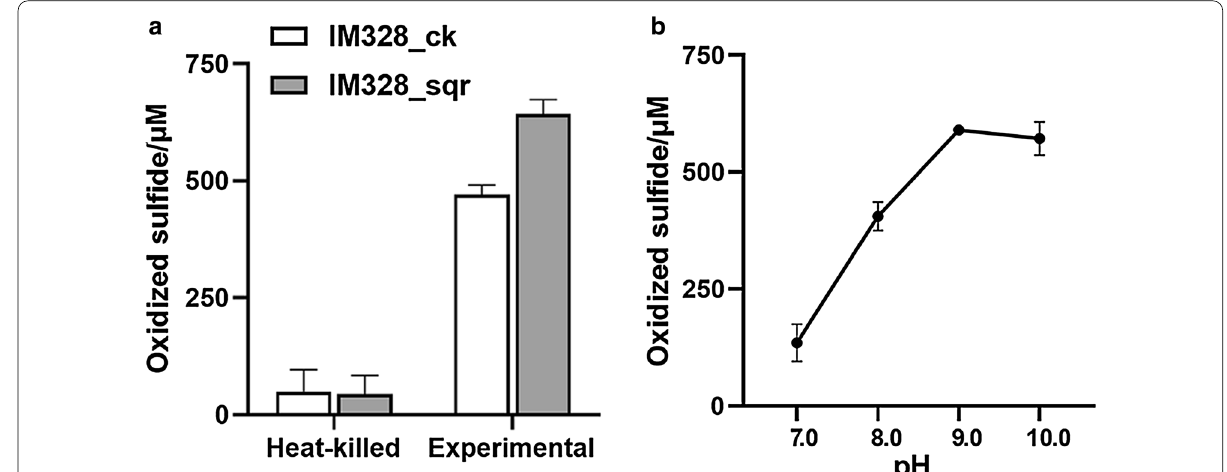
Fig. 6 Sulfide oxidation by H . salifodinae IM328_sqr. The experiments were carried out in the 1.5 mL centrifuge tube. Na 2 S was added to 1000 µM to initiate the reaction. Detection and calculation of the sulfide contents consumed in the reaction system were done after 5 min. a Comparison of the desulfurizing activity of IM328_sqr and IM328_ck under aerobic conditions. Sulfide oxidation by live and heated killed cells. Cells were harvested from LB-60, washed and resuspended in 1 mL of 25 mM tricine buffer (pH 8.0) at 37 °C, 200 rpm. The biomass was equivalent for H . salifodinae IM328_sqr and IM328_ck (OD 600 of approximate 4). b Optimization of the pH value of the whole-cell catalysis of IM328_sqr. Cells were resuspended at OD